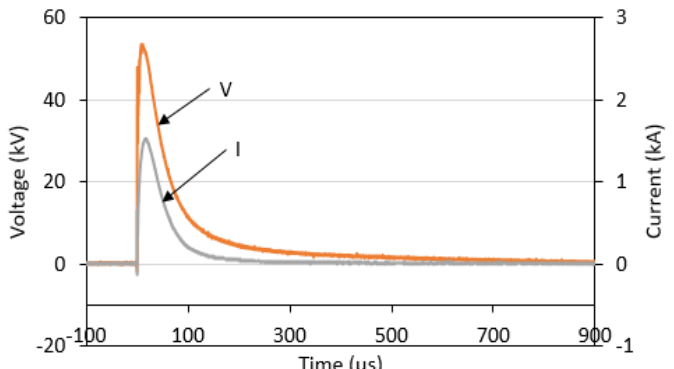
Figure 7. Voltage and current traces of the NC electrode at 100 kV charging voltage.